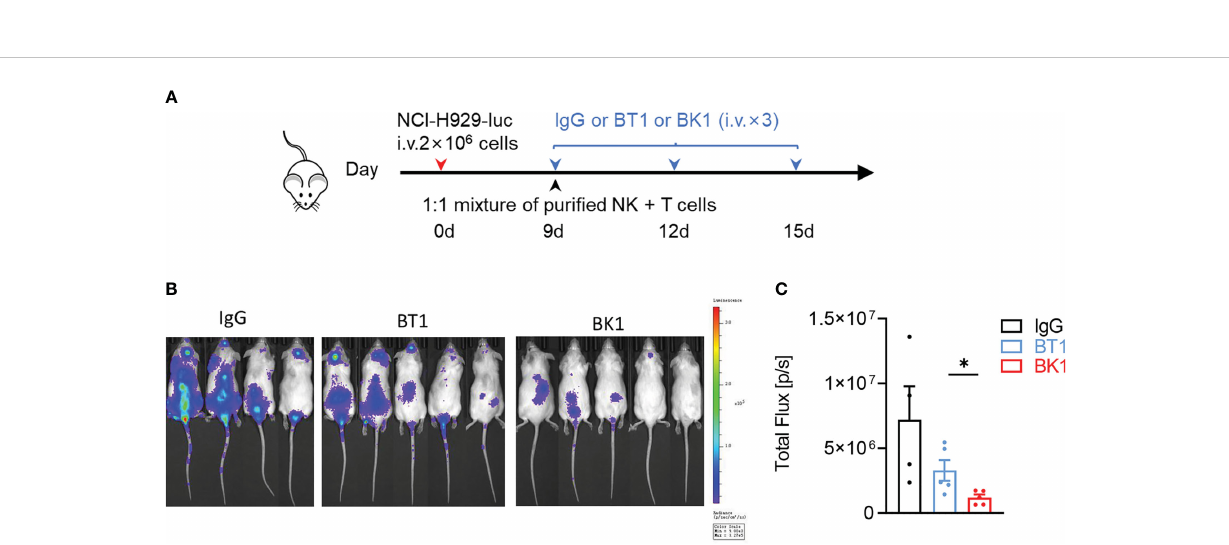
FIGURE 4 BK1 (BCMA×CD16A) shows a stronger antitumor effect than BT1 (BCMA×CD3) in an NK and T-cell mixture-reconstituted xenogeneic tumor model. (A) Experimental protocol for the tumor model used in (A – C) . NSG mice were injected intravenously (i.v.) with NCI-H929-luc tumor cells (2 × 10 6 ) on day 0 followed by intravenous injection of a 1:1 mixture of puri fi ed NK and T cells (5 × 10 5 each) on day 9. Tumor-bearing mice were injected intravenously (i.v.) with IgG, BT1 or BK1 (50 m g/mouse) every 3 days for a total of 3 doses beginning on day 9. (B) In vivo bioluminescence imaging of mice 13 days after tumor challenge described in (A) . (C) Quanti fi cation of luminescence in IgG-treated, BT1-treated or BK1-treated mice on day 13. Each symbol represents an individual mouse. (B, C) Data are representative of at least three independent experiments. Data were analyzed by Student ’ s t test *P < 0.05.